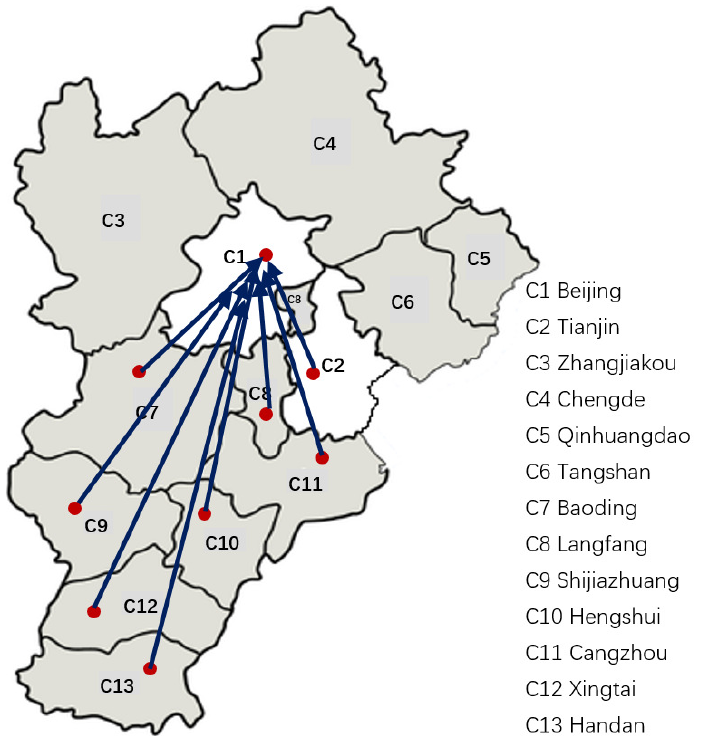
Figure 6. Sequential order for the occurrence of extreme ozone pollution between Beijing and other cities during April and